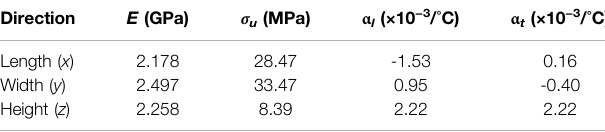
TABLE 1 | Anisotropic material properties of additively manufactured ABS specimens.